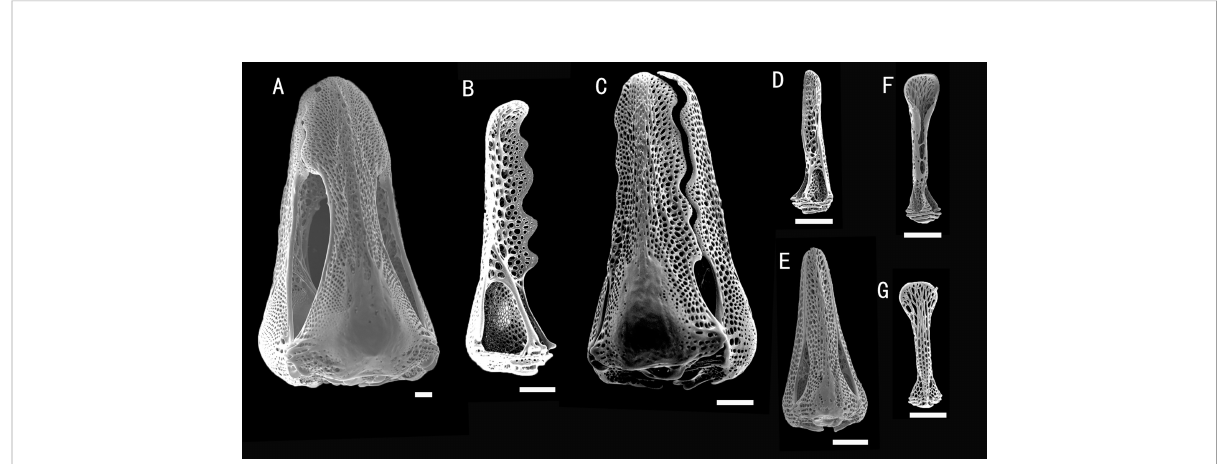
FIGURE 10 Araeosoma alternatum , MBM286966. SEM images of pedicellariae. (A) Large involute tridentate pedicellaria. (B, C) Large rostrate tridentate pedicellaria: (B) individual valve (C) head. (D, E) Small tridentate pedicellaria: (D) individual valve (E) head. (F, G) Valves of triphyllous pedicellariae. Scale bar , 100 m